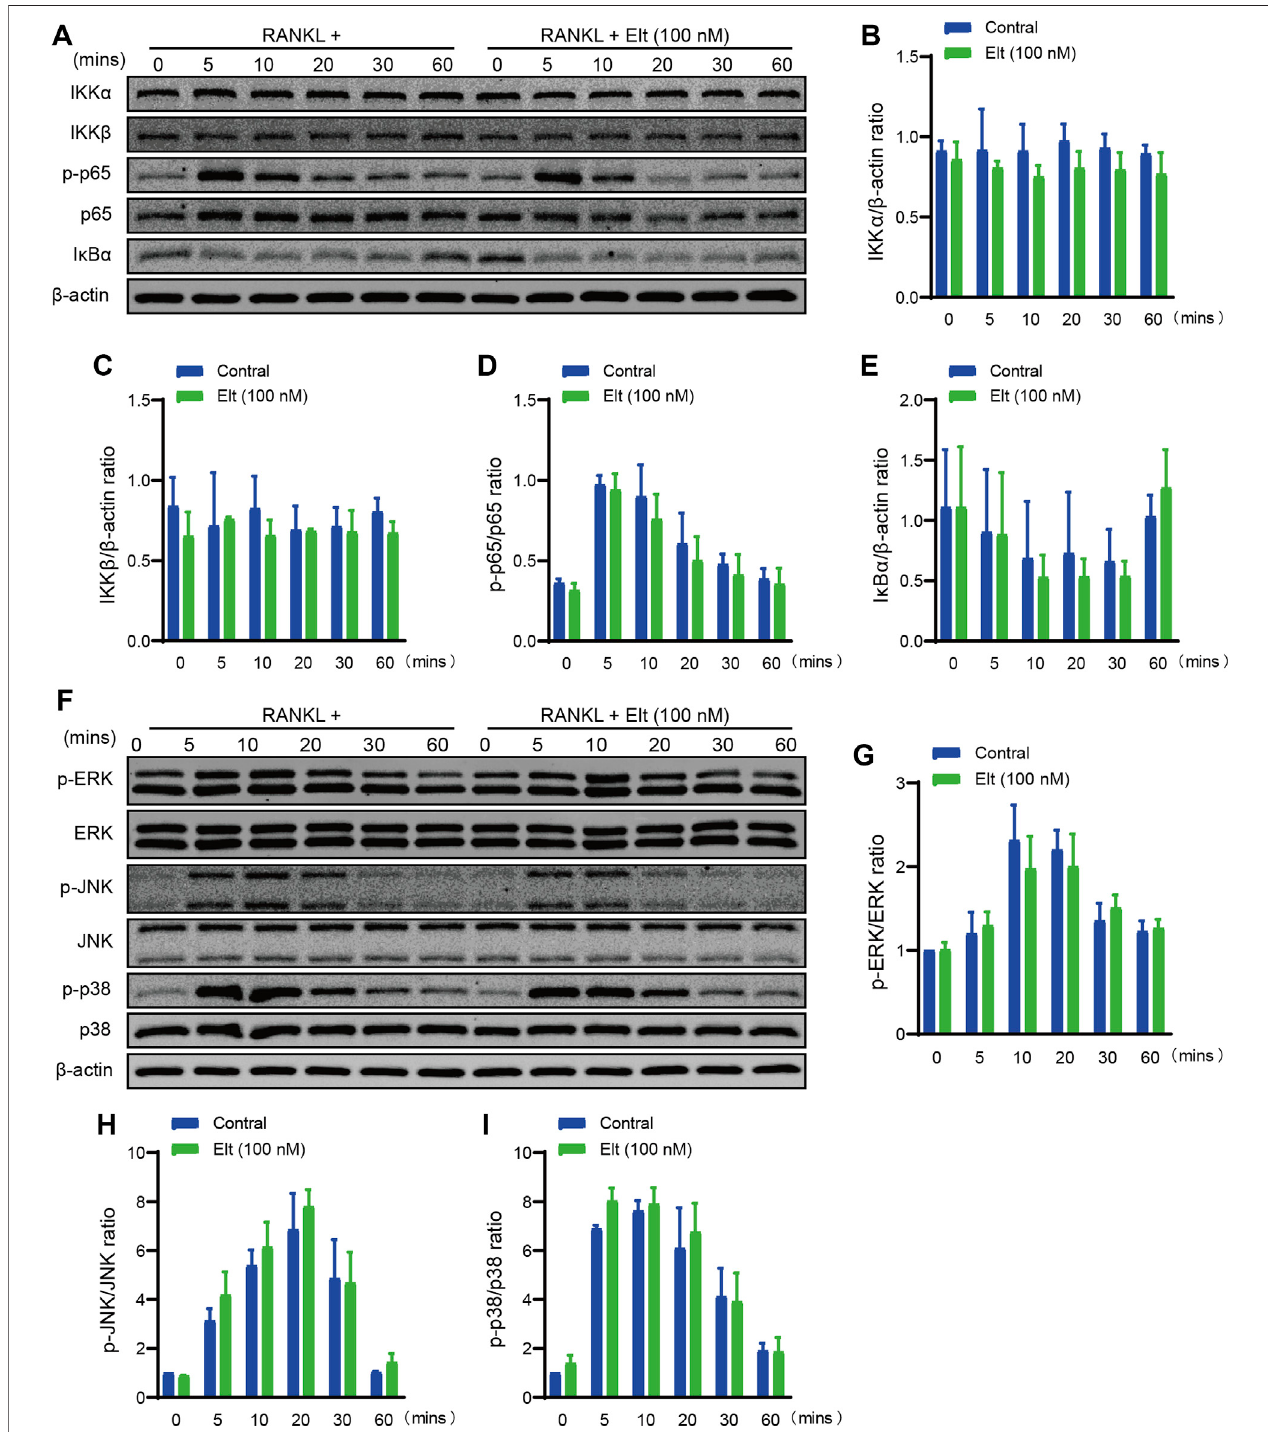
FIGURE 5 | Elt does not markedly affectthe initiation of NF- κ B and MAPK signaling pathways by RANKL. (A) Representative Western Blot images of the effects of Elt on NF- κ B pathways induced by RANKL within 60 min. (B – E) The quantitative analysis of IKK α , IKK β , I κ B α and p-p65 expression between the Elt-treated group and control group. (F) Representative Western Blot images of the effects of Elt on MAPK pathways induced by RANKL. (G – I) Quanti fi cation of the ratio of phosphorylated ERK, JNK and p38 to the correspondingtotal protein band. The above data are expressed asthe mean ± SD; n = 3; Signi fi cant differencesbetween the treatment and control groups are indicated as *p <